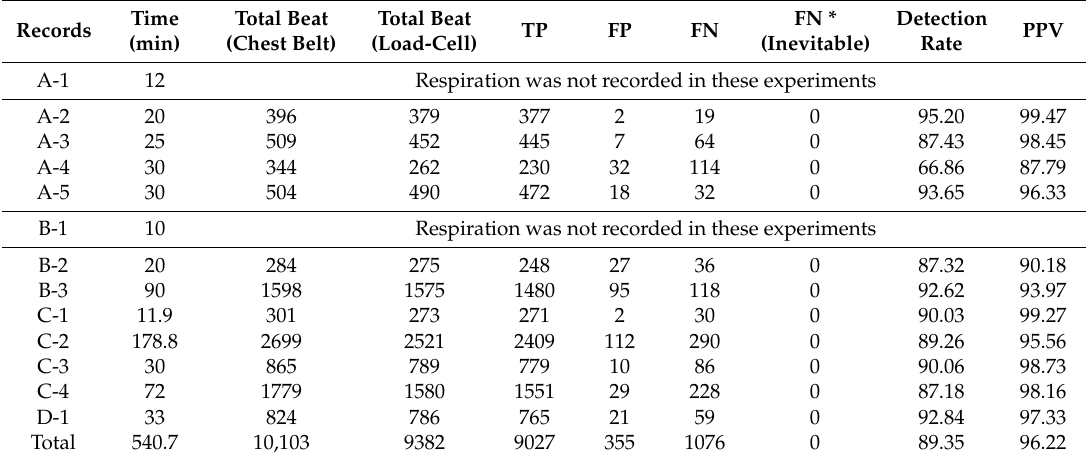
Table 4. Performance evaluation results with respect to the beat locations in BR